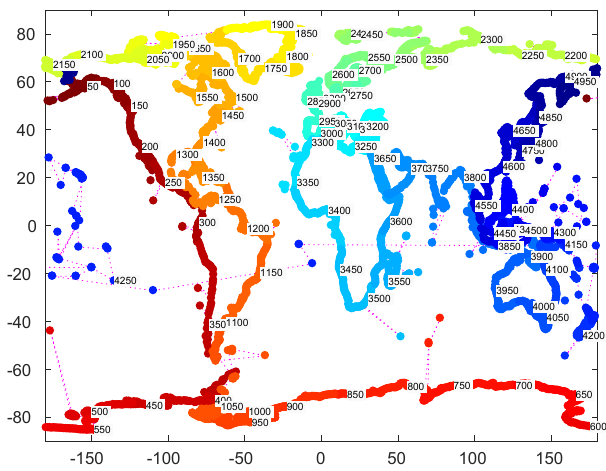
Figure A1. Sites used for analysis showing the order of coastal points (red to blue points shown above correspond to top to bottom in Figs. 1, 4, and